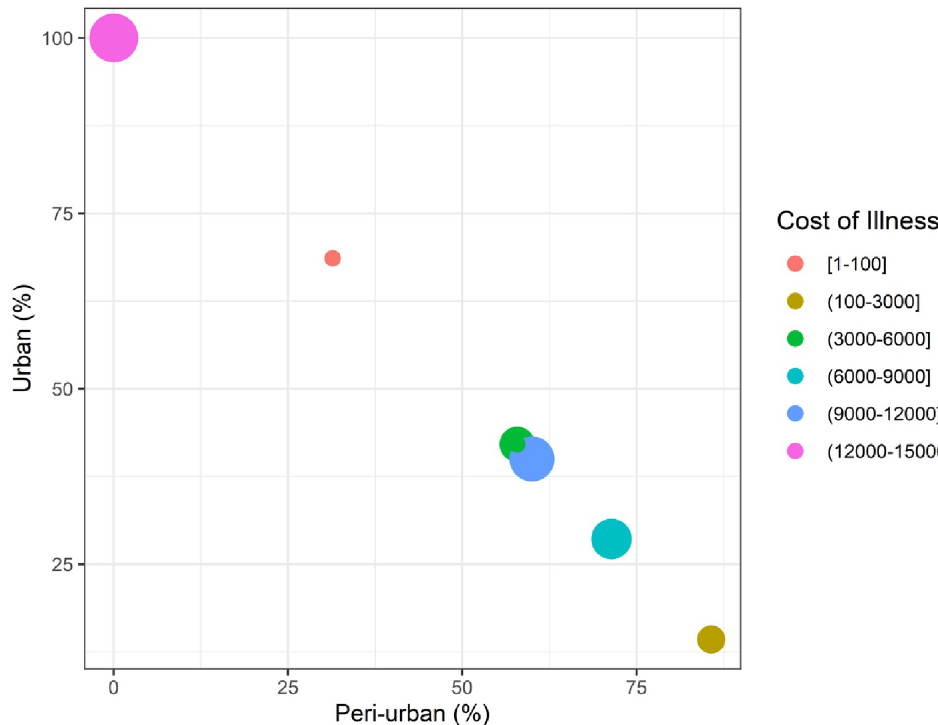
Fig 1. Distribution of cost of illness and social cost of households among urban and peri-urban communities.